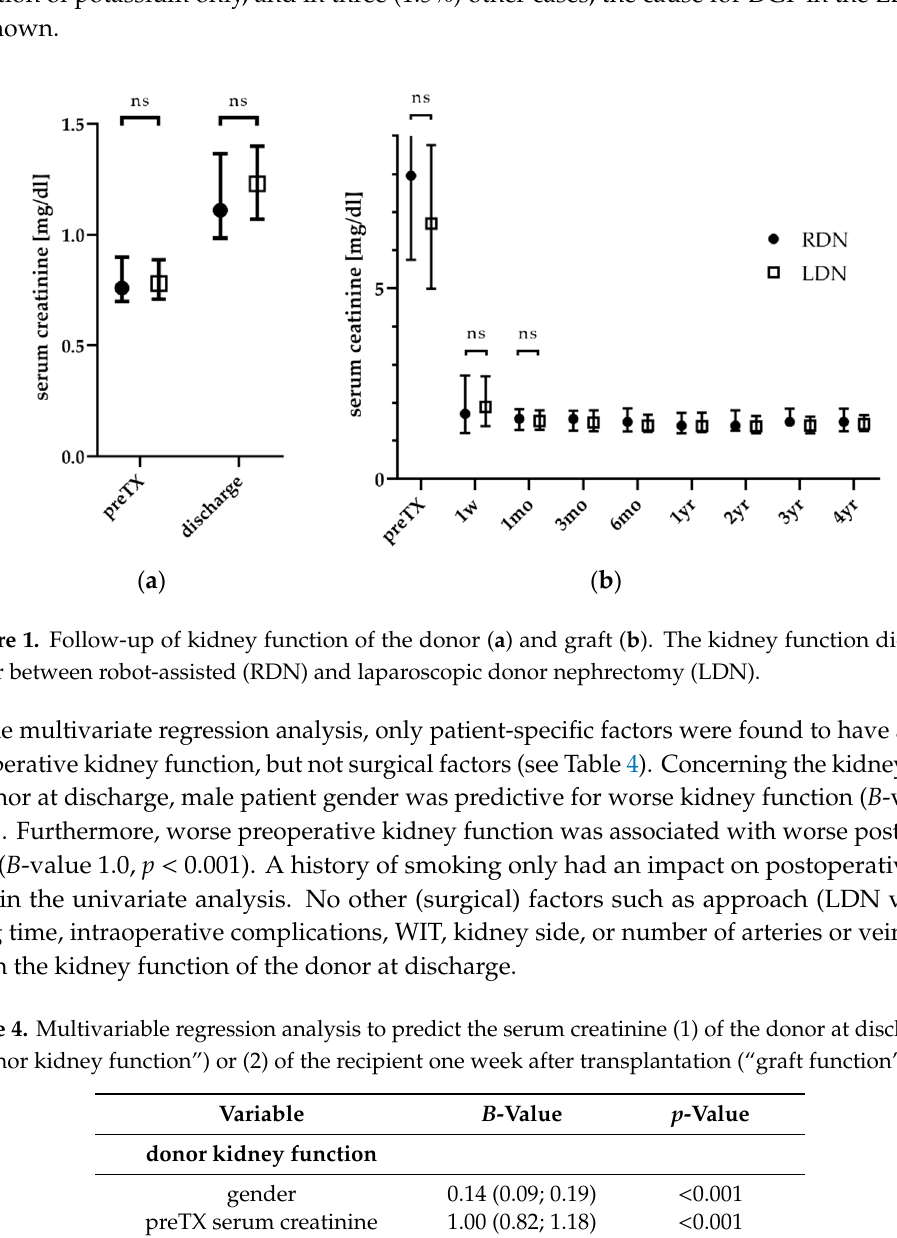
Table 4. Multivariable regression analysis to predict the serum creatinine (1) of the donor at discharge (“donor kidney function”) or (2) of the recipient one week after transplantation (“graft function”). Variable B -Value p -Value donor kidney function gender 0.14 (0.09; 0.19) <0.001 preTX serum creatinine 1.00 (0.82; 1.18) surgical approach - n.s. graft function smoking donor 0.63 (1.21;